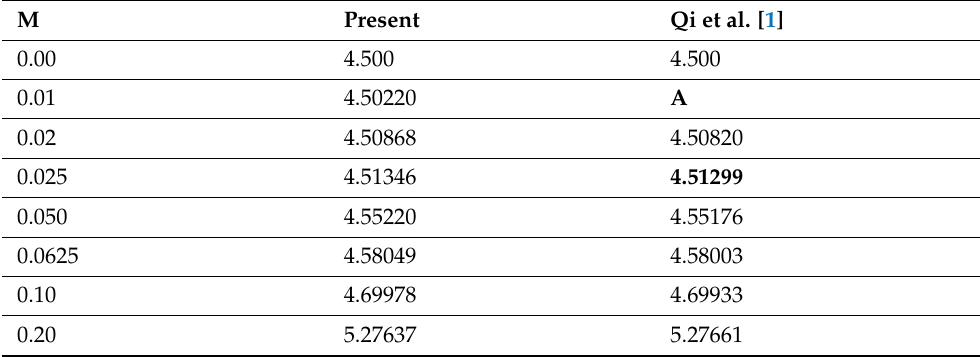
Table 1. Comparison of the presently calculated results for α i for hydrogen atom for various values of µ , using 20 terms in the wave